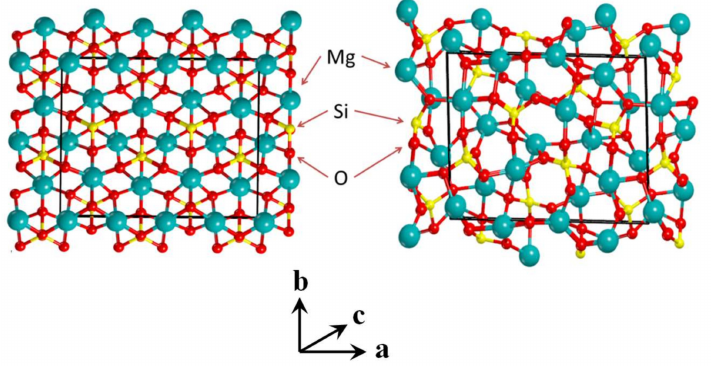
Figure 4. B3LYP-optimized structures of Mg 2 SiO 4 bulk structure in the crystal form (left) and in an amorphous form (right) generated by classical MD simulations at T = 1800 K. Unit cells are shown in black. Table 2. Bond distance ranges and cell parameters of the Mg 2 SiO 4 bulk structures: experimental values of the crystal system as well as B3LYP-optimized values of the crystal and amorphous systems. The calculated volume and densities derived from the B3LYP-optimized geometries are also